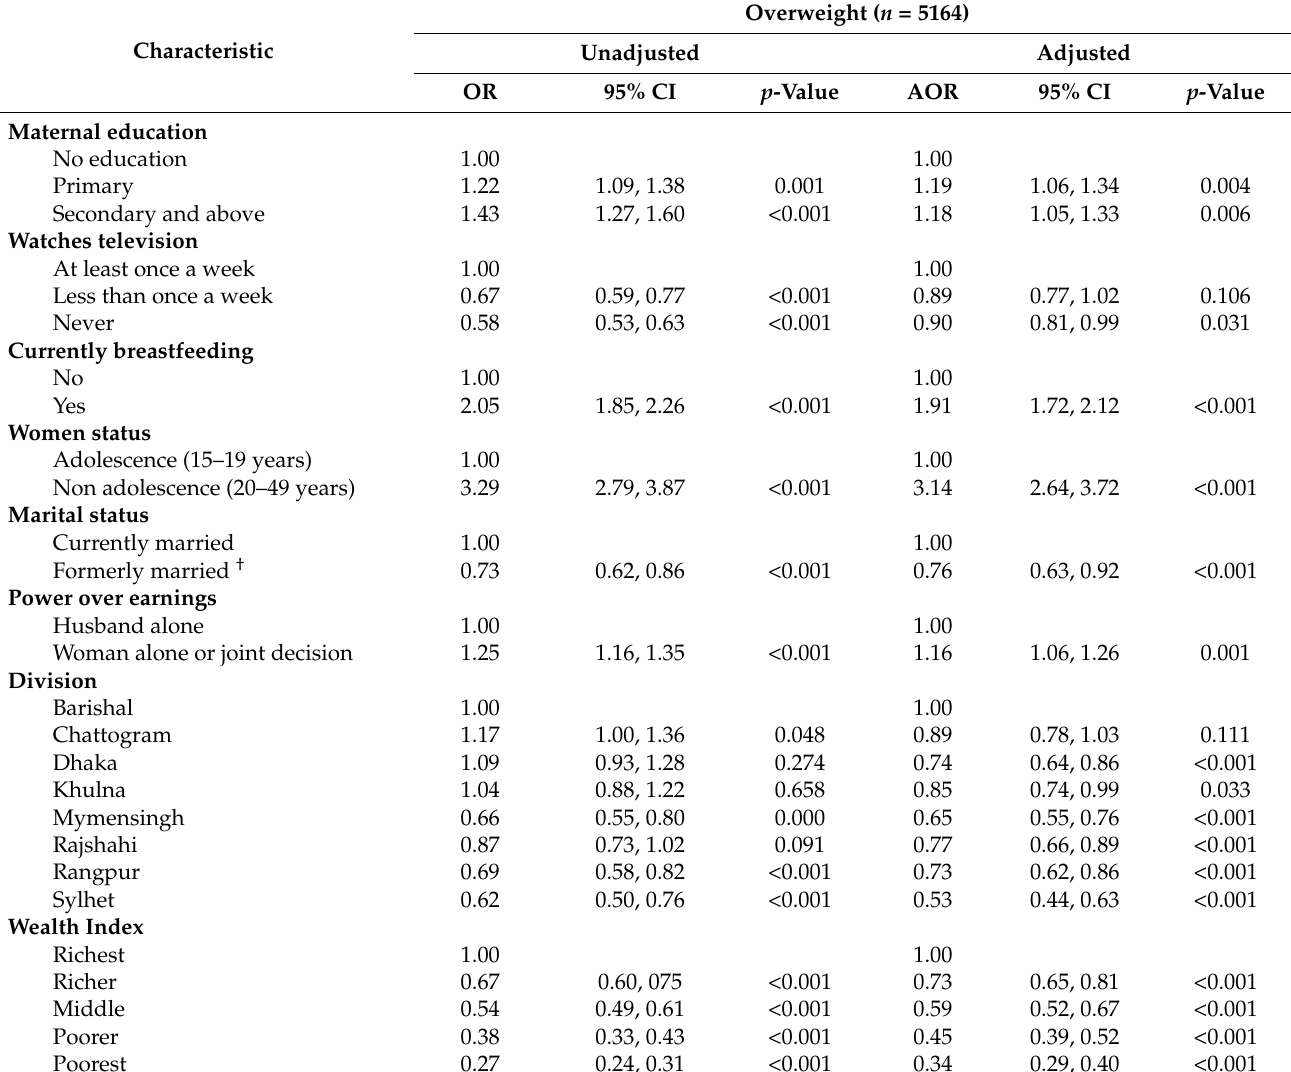
Table 3. Survey logistic modeling of reproductive-age women being overweight: unadjusted (OR) and adjusted Odds Ratios (aOR), Bangladesh